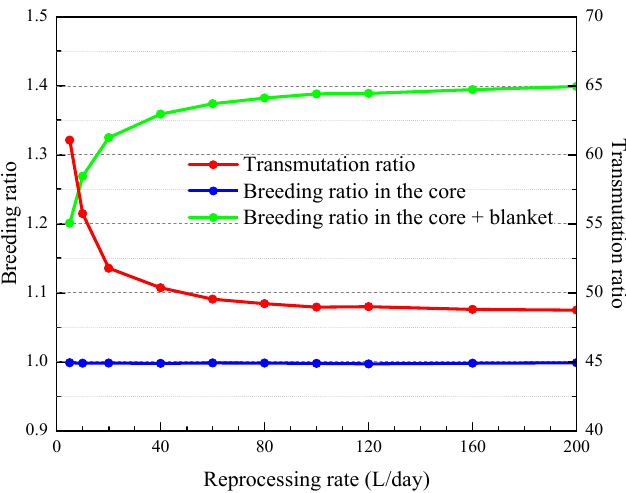
Figure 9. Influence of the reprocessing rate on the breeding ratio and transmutation ratio. Table 7. Transmutation ratio of TRU.